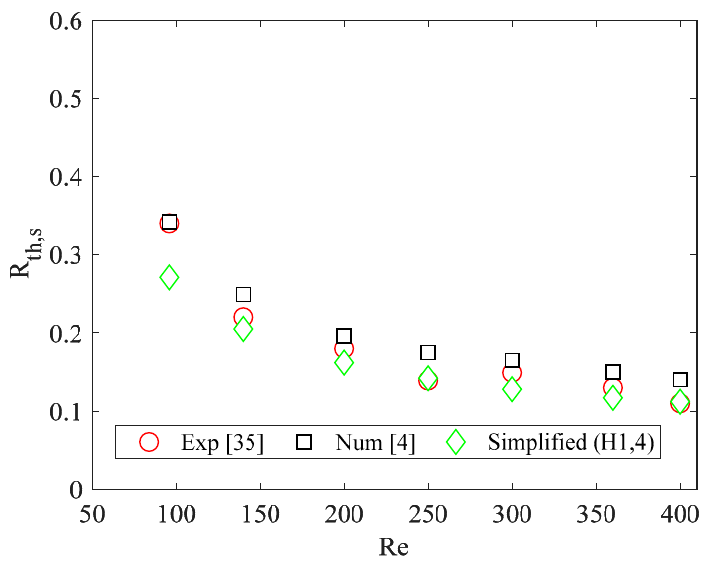
Figure 3. Thermal resistance of heat sink (°C cm 2 /W): comparison between results of the simplified model, numerical data obtained by considering conjugate heat transfer [4], and experimental data [35]. Reproduced with permission from [4].